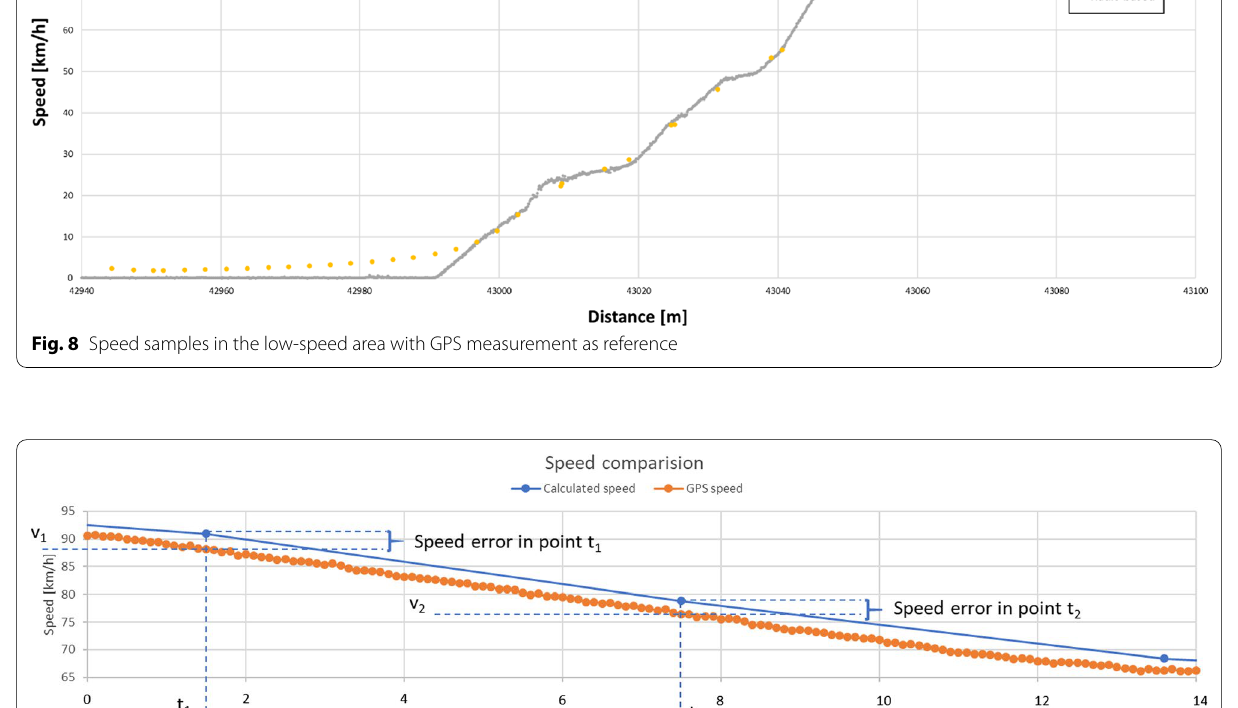
gps train speed at time point t 1 (m/s), v 2 =